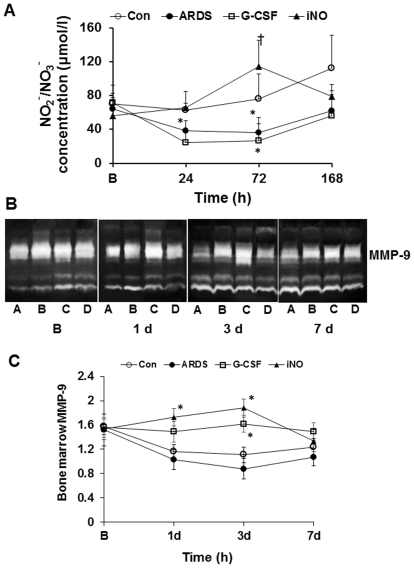
Effects of iNO on NO2
−/NO3
− and MMP-9 in bone marrow.(A) In the iNO group, the NO2
−/NO3
− concentration was increased at 72 h compared to the ARDS group. In the ARDS group, the NO2
−/NO3
− level decreased at 24 and 72 h compared to baseline. (B) MMP-9 expression measured by Zymography in bone marrow, A–D represent ARDS, G-CSF, iNO and Con, respectively. (C) Inhaled NO enhanced the MMP-9 expression at day 1 and 3. (* P<0.05 vs. B; † P<0.05 vs. ARDS group. n = 5–6 in each group).